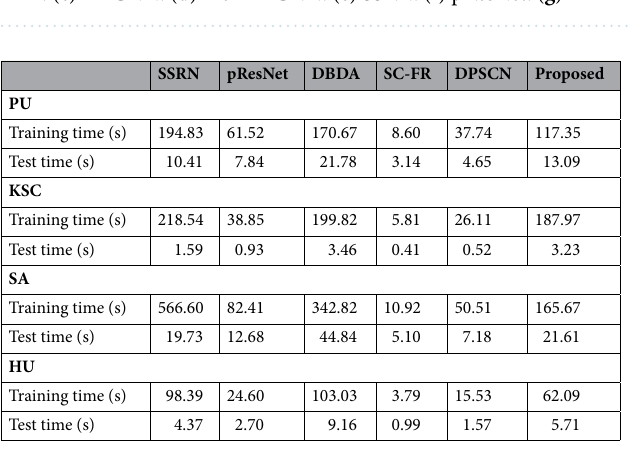
Table 9. Training time, and test time for different models on the four data sets.